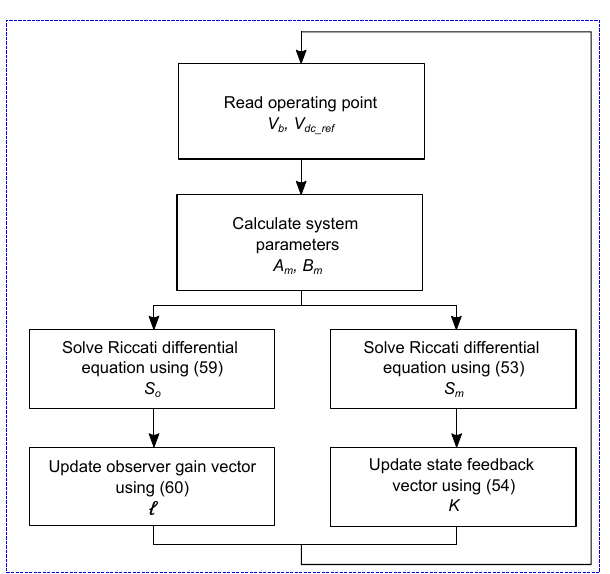
Figure 9. Flowchart to calculate the adaptive parameters of the LQI